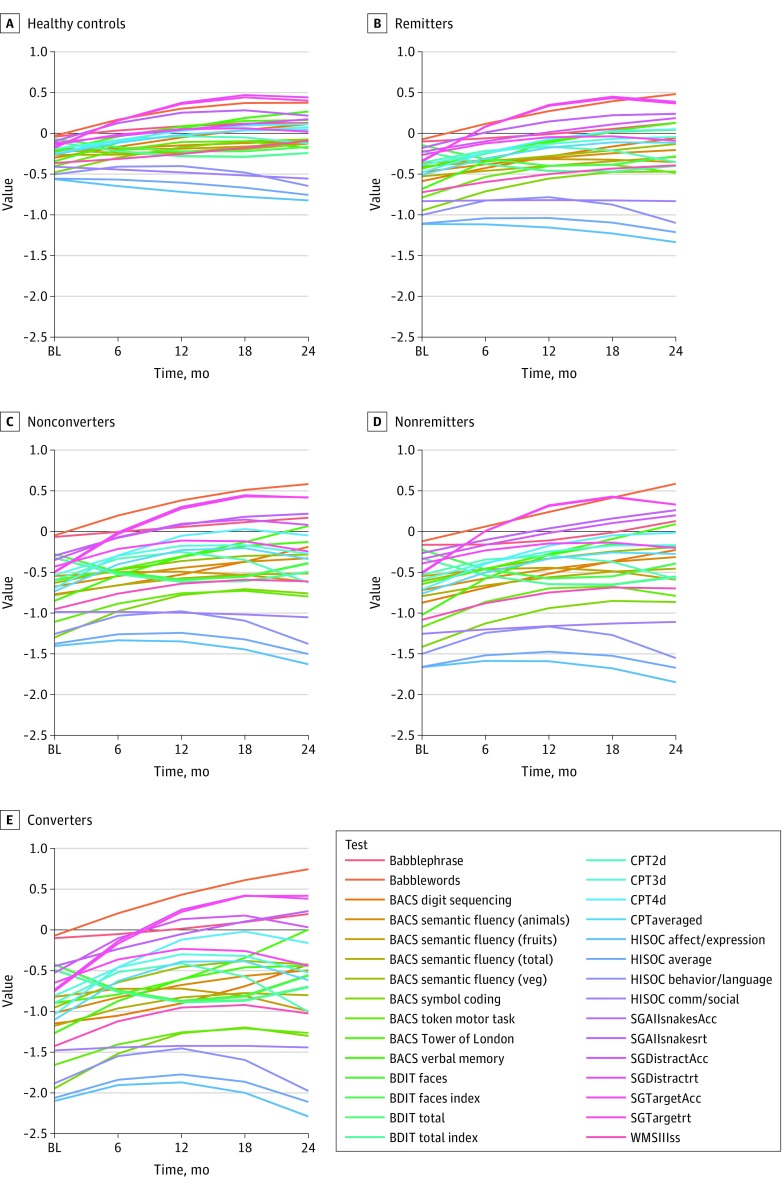
Cognitive Trajectories of Individual Tests Over 24-Month Follow-upA, Healthy controls. B, Remitters. C, Nonconverters. D, Nonremitters. E, Converters.
Each test is color-coded. Individual lines reflect estimated cognitive scores for each
test computed on the basis of linear mixed model outputs for each test. Babble
indicates Babble Task; BACS, Brief Assessment of Cognition for Schizophrenia; BDIT,
Binocular Depth Inversion Task; CPT, Continuous Performance Task: 2d, 2Digit, 3d,
3Digit, 4d, 4 Digit subtasks; HISOC, High Risk Social Challenge; SG, Snakes in the
Grass test; Acc, Accuracy; rt, reaction time; and WMSIIIss, Wechsler Memory Scale
– III Spatial Span.